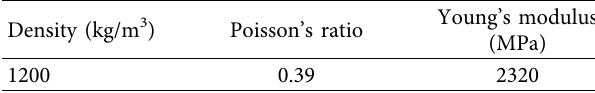
Figure 10: Diagram of the experimental scene. Table 2: Material parameters of the scaling